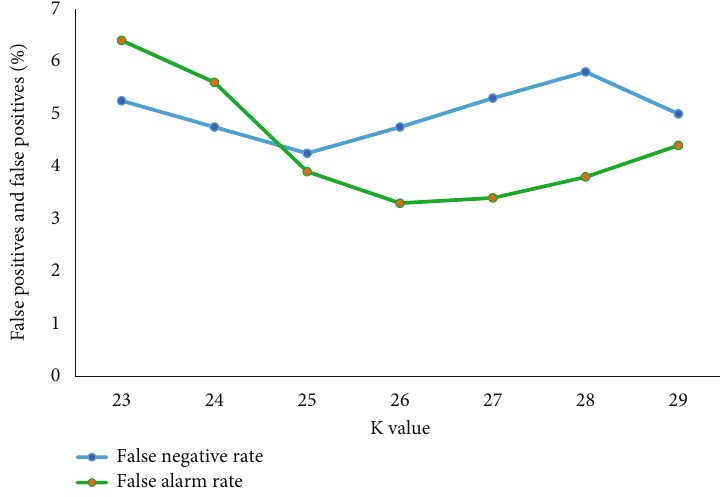
Figure 6: Average false negative rate and false positive rate for di ff erent K values.